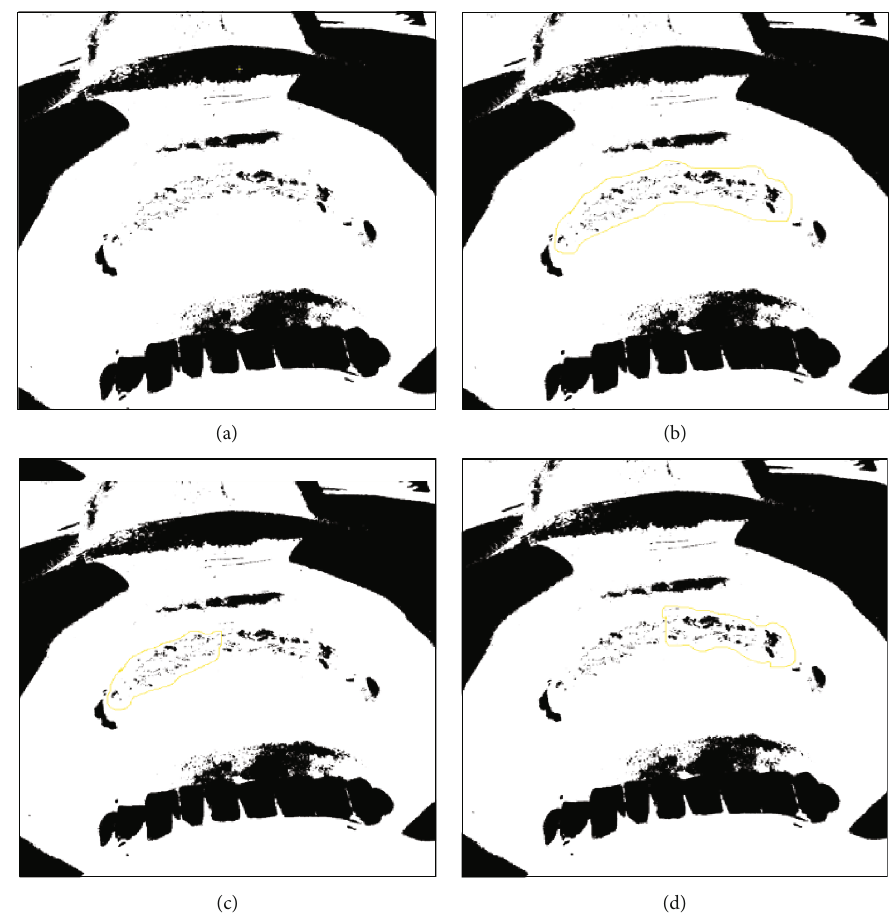
Figure 2: Analysis of images using the ImageJ® program for red pixels. (a) Image obtained after the appropriate adjustment of the red color scale; the software turns the area of interest to black and the other areas to white. (b) Segmentation of the total area of interest to obtain the total amount of red pixels. (c) Segmentation of the right area (test side) to obtain red pixels. (d) Segmentation of the left region (control side) to obtain red pixels in this area.